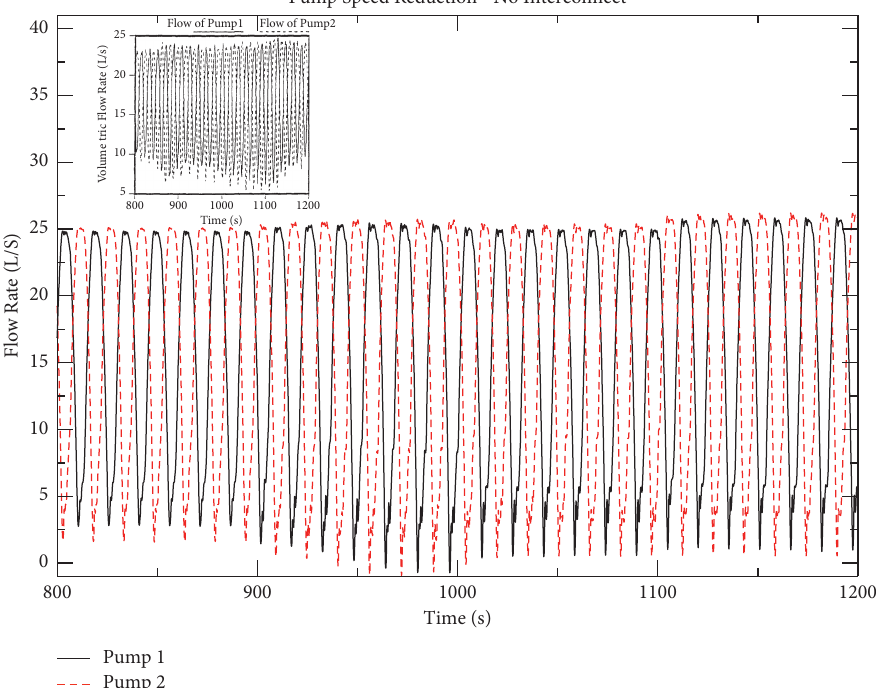
Figure 35: Flow oscillations with reduced pump speed. Experiment inset